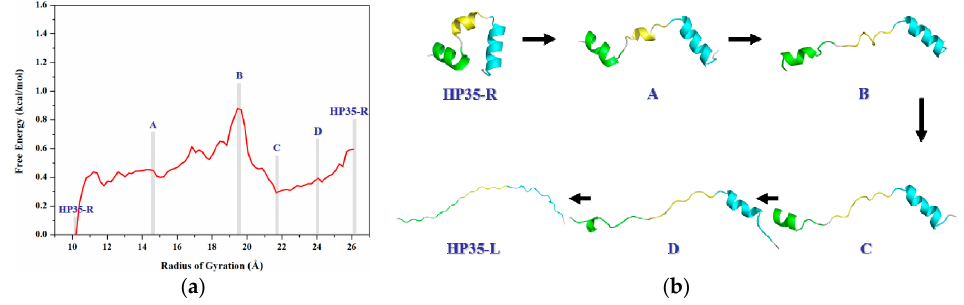
Figure 6. Probability distribution of the radius of gyration ( R g ) for four representative umbrella sampling simulations centered at R g = 12.0, 16.0, 20.0, 24.0 Å for four selected force constants of 0.02, 0.1, 0.5, 1.0 kcal/(mol·Å 2 ), respectively.